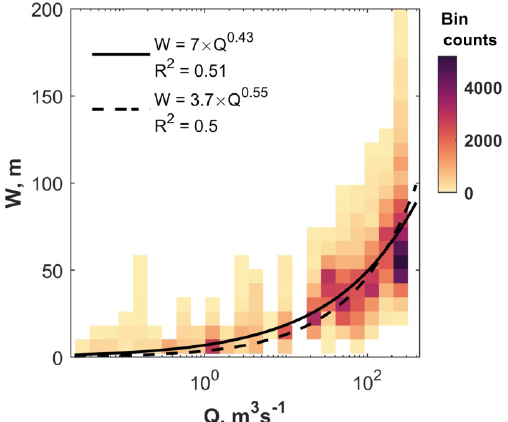
Figure 3. Normalized steepness ( k sn ) for the Paute basin. Calcu- lated k sn values for the Paute basin are overlain with a hillshade map (based on the 30m SRTM v3 DEM; Farr et al., 2007). The highest values can be observed in two major knickzones located in the lower part of the Paute basin. In these zones, topographic reju- venation started and a transient incision pulse has propagated from east to west (see also Fig. S3). The map is produced with Topo Tool- box (Schwanghart and Scherler, 2014).